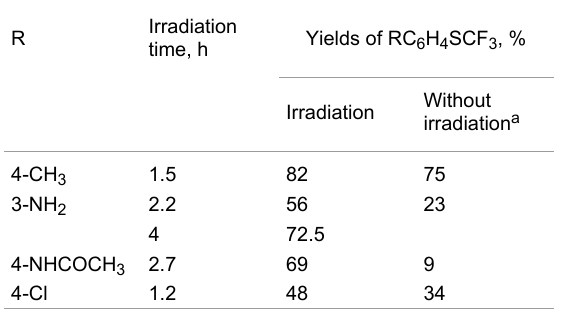
Reagents Yield of ArSR F , %